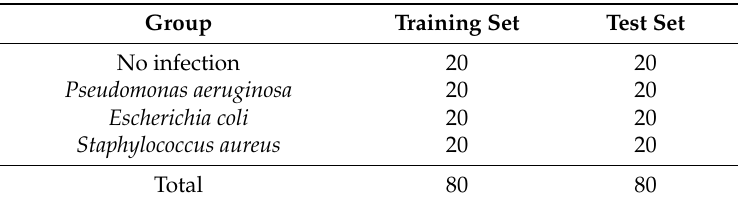
Table 1. Number of samples in Dataset I.